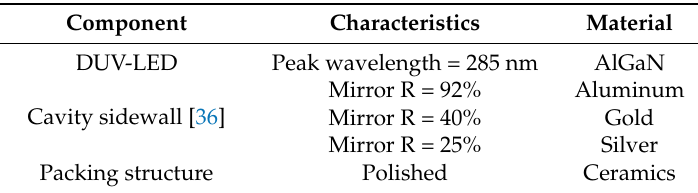
Figure 3. DUV-LEDs’ relative far-field emission pattern (arb. unit). Table 1. Surface and material characteristics of all components in the reflector cavity of the proposed deep-ultraviolet light-emitting diodes (DUV-LED).